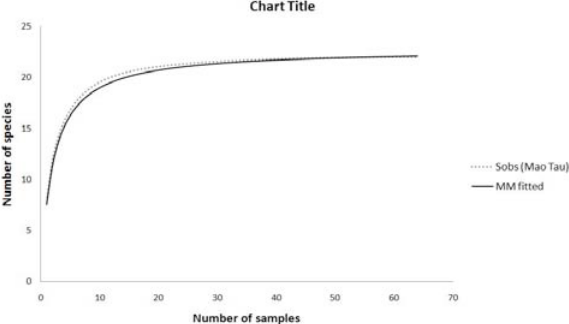
Figure 2(b). Species accumulation curve – samples vs. species richness (dotted grey line indicates observed species mean and black solid line indicates Michaelis-Menten mean).